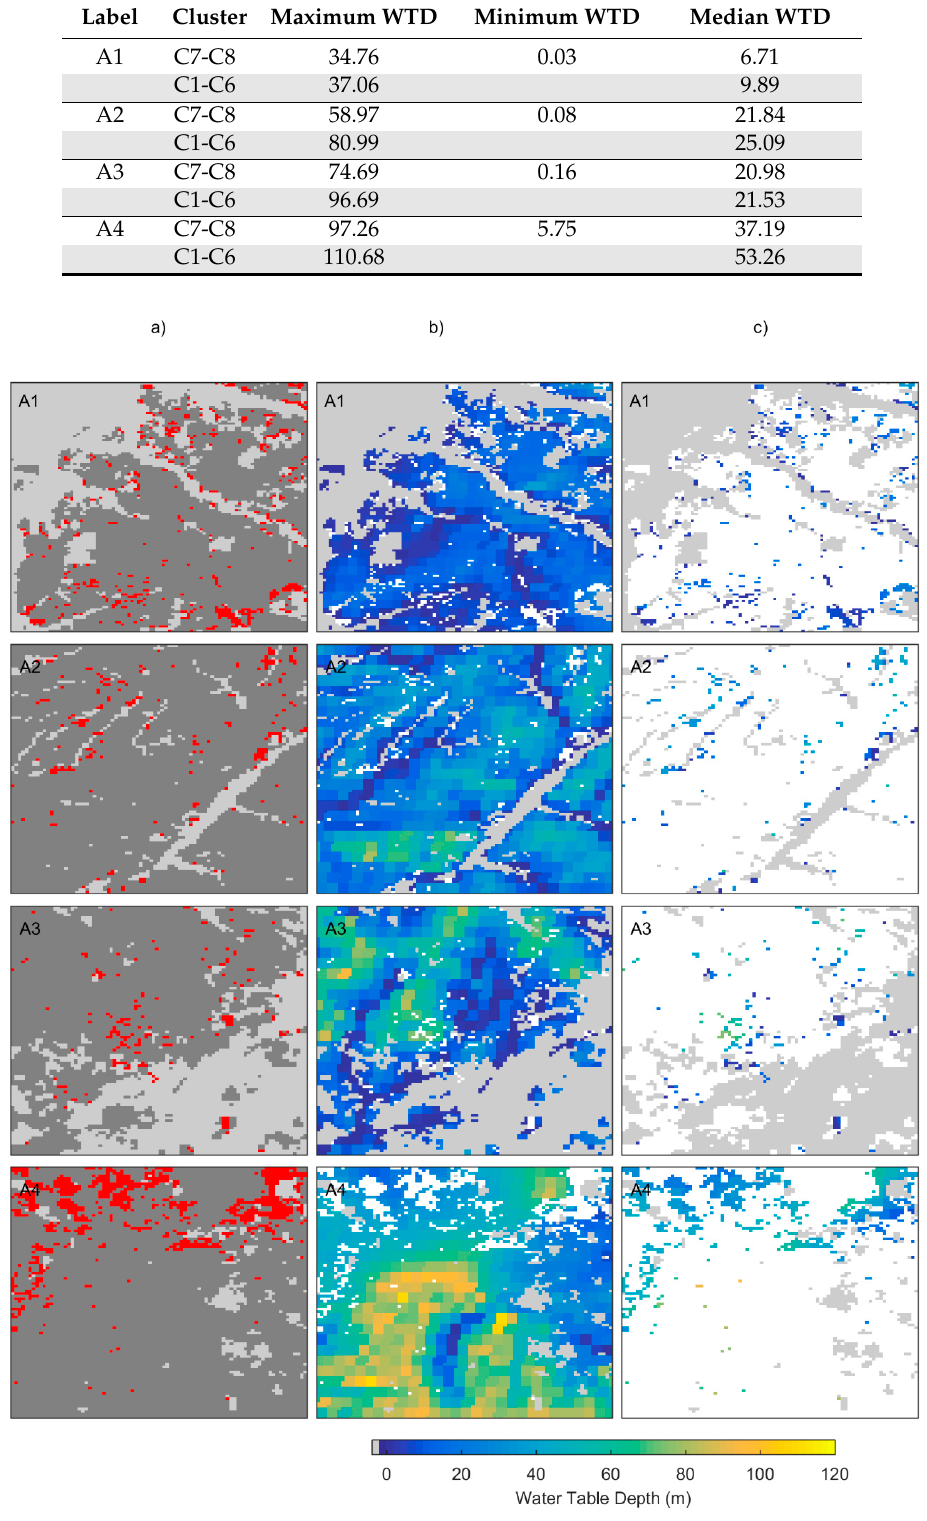
Figure 8. ( a ) Pixels identified as C7 and C8 (red) and as C1 to C6 (dark gray). ( b ) Water table depth in the areas classified as C1 to C6 and ( c ) as C7 to C8. Pixels shown as light gray were previously excluded from the study area.